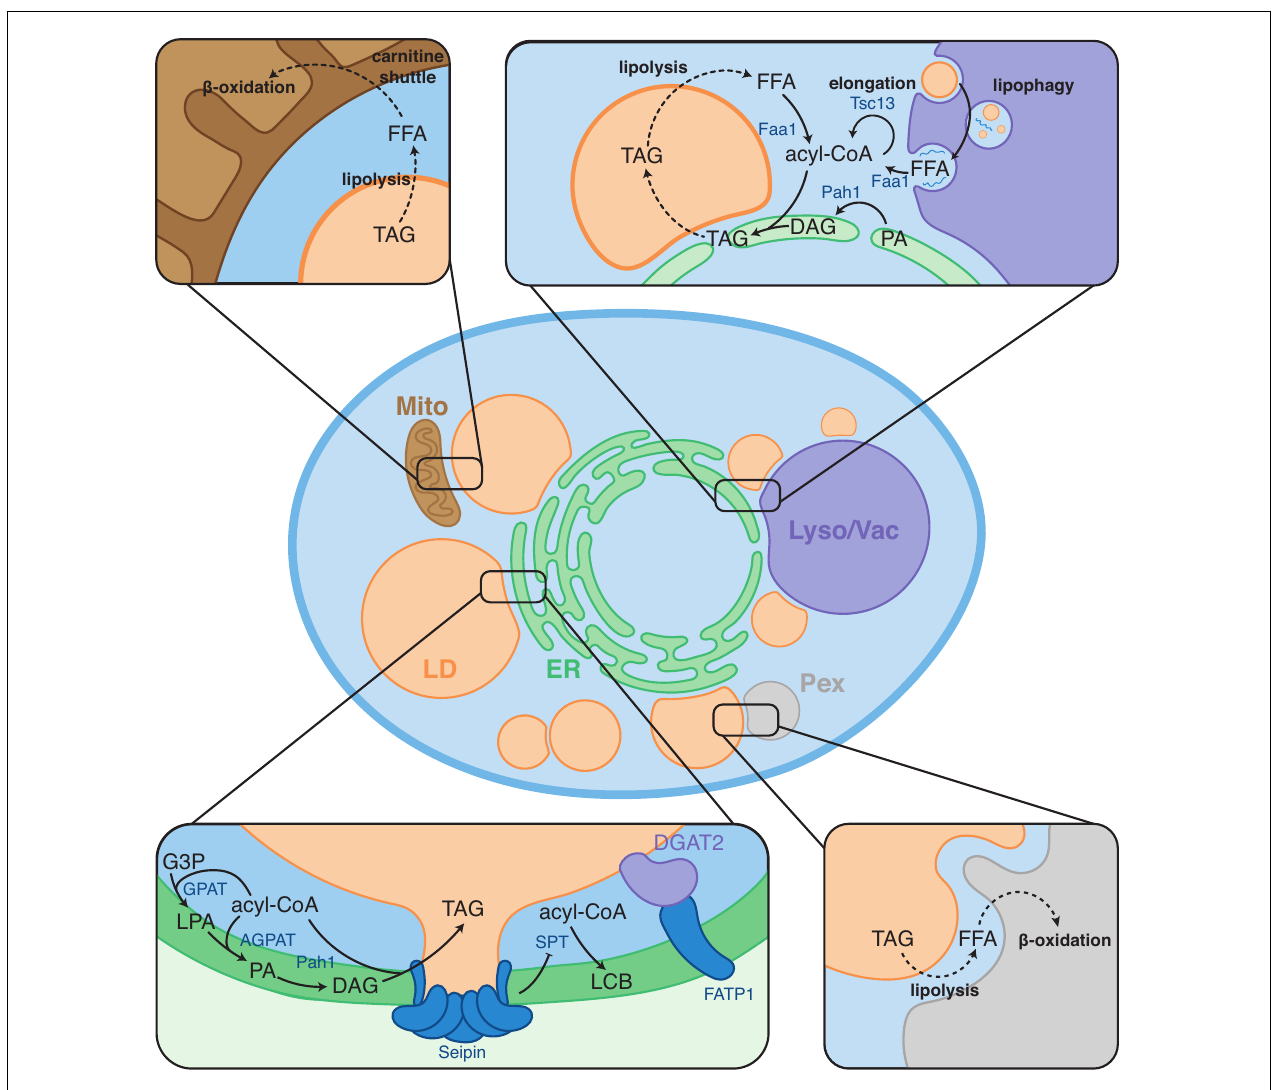
FIGURE 1 | Overview of FA metabolic steps taking place at LD contact sites. LDs form contact sites with the endoplasmic reticulum (ER), mitochondria (Mito), peroxisomes (Pex), and lysosome/vacuole (Lyso/Vac). Boxes show examples of FA metabolic processes taking place at these contact sites. Arrows indicate enzymatic conversions; dashed arrows indicate trafficking/transport